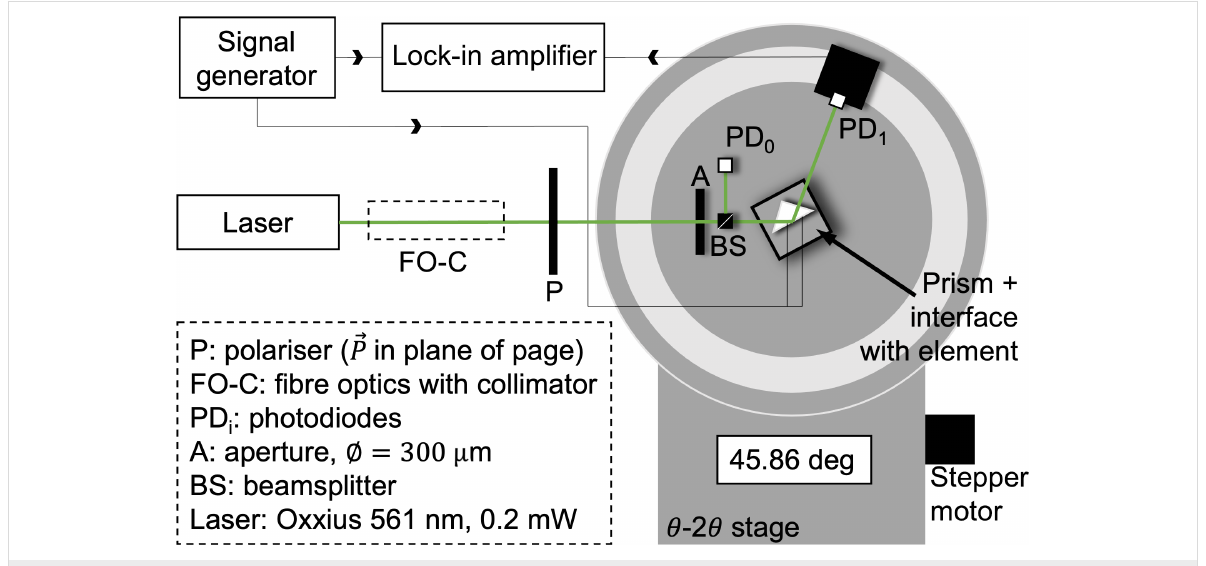
Figure 2: A schematic of the enhanced SPR experiment.